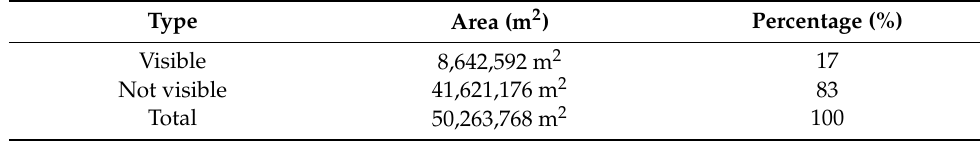
Figure 9. Visual basin with a radius of 4 km generated from two maximum points identified at the northern (76 m) and southern (88 m) ends. Table 3. Results obtained from the visual basin.